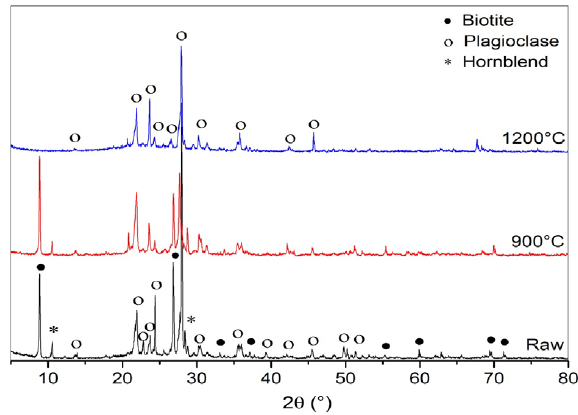
Figure 3. X-ray diffraction (XRD) analysis of Sille stone Figure 3: X-ray diffraction (XRD) analysis of Sille